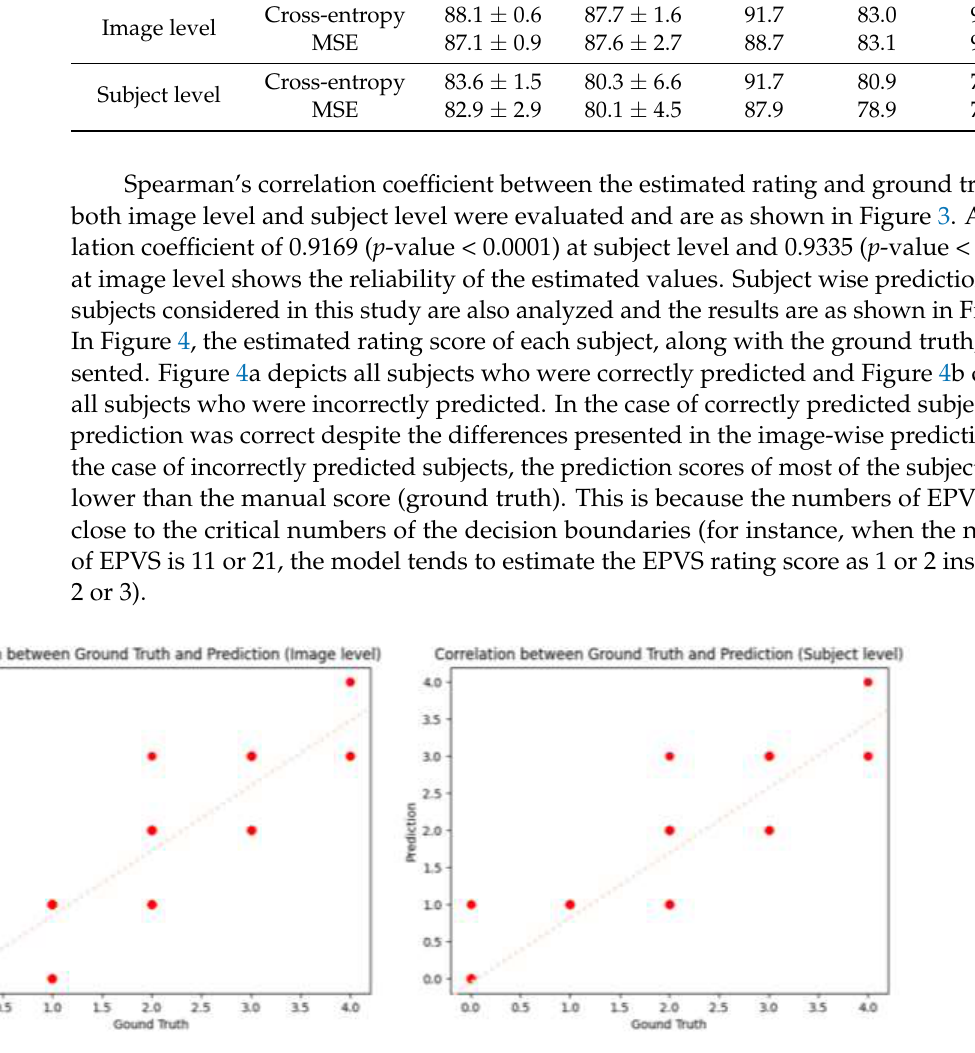
Figure 4. The prediction results of individual subjects: ( a ) All correctly predicted subjects (vertical axis; the number of images indicates the number of incorrectly predicted images per subject (out of six images per subject)). At subject level, all these subjects were rated correctly, although there were some incorrect predictions at image level. ( b ) All incorrectly predicted subjects (numbers corresponding to each subject in the brackets shows the number of EPVS found in each im- age). The numbers highlighted red and purple are the incorrect EPVS numbers identified in the corresponding image that